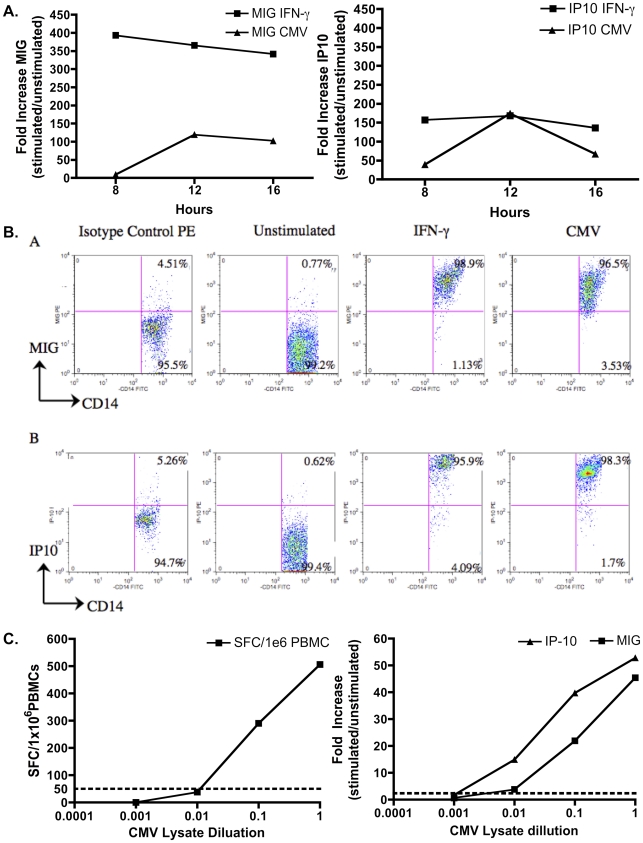
Development of a novel assay for the detection of antigen-specific T cells.a. Time course of cytokine-induced as compared to antigen-induced MIG and IP10 expression. qPCR analysis of MIG (left) or IP10 (right) mRNA obtained from PBMCs stimulated with 10 ng/mL IFN-γ or 10 µl/ml CMV whole cell lysate for 8, 12 and 16 hours. b. FACs analysis of MIG (top) and IP10 (bottom) in CD14+ Monocytes cultured for 16 hours with 10 ng/ml IFN-γ or 10 µl/ml CMV lysate. Monocytes were gated based on forward and side scatter. Cells were stained with mAb to CD14, fix and permeabilized, and stained with mAbs specific for MIG or IP10. Cells gated within the monocytes/macrophage regions were evaluated for MIG and IP10 expression. Isotype antibody for MIG and IP10 was used to control for non-specific binding. c. IFN-γ Elispot (left) and IP10/MIG qPCR (right) to serially diluted CMV lysate. The data shown represents that average of two independent experiments. Variation between experiments was insignificant, as measured by a Paired t-Test (P>0.05). The parallel line indicates a cut-off of 50SFC/106 PBMCs for the IFN-γ Elispot (left). For qPCR (right), a test assay cut-off of mean + 3SD was used (MIG ESAT-6 = 1.5361; MIG CFP-10 = 2.9748; IP10 ESAT-6 = 2.9244; IP10 CFP-10 3.1709).